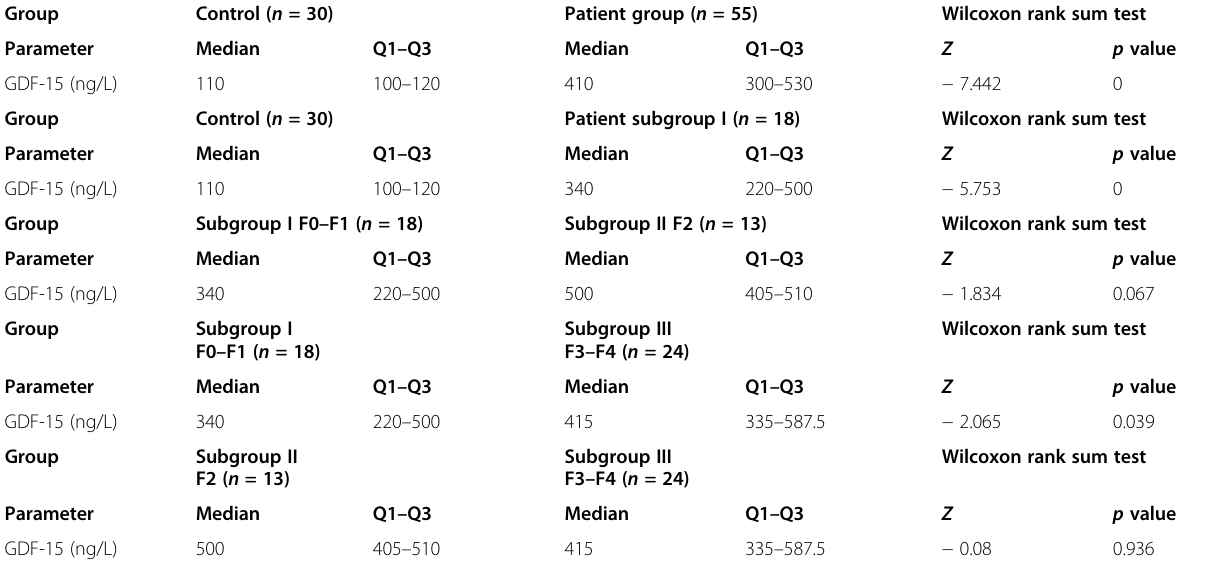
Table 3 Comparative statistics of GDF-15 between control group and whole patients ’ group and between each two patients ’ sub- groups using Wilcoxon ’ s rank sum test